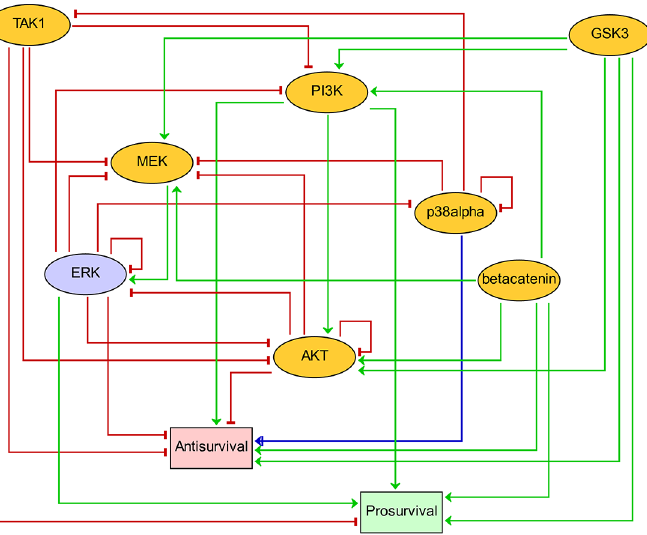
Fig 3. Reduced logical model obtained by semi-automated reduction of the comprehensive logical model shown in Fig 2. The reduced model encompasses all seven drug targets (yellow) and the two phenotypic outputs (red for Antisurvival and green for Prosurvival). In addition the ERK node (blue) had to be preserved to maintain dynamical consistency with the large model. Activating regulations are denoted by green arrows, while red T arrows denote inhibition. The blue arc with both arrow and T head (p38alpha to Antisurvival) indicates a dual regulation, i.e. activating and inhibiting, depending on context. In some contexts p38alpha inhibition will increase Antisurvival, while in others p38alpha inhibition will decrease Antisurvival (see S1 Text, S7 and S8 Tables). Note that after model reduction two members of the Wnt/ β -catenin pathway, β -catenin and GSK3, became non-regulated and fixed at either the on-state ( β -catenin) or off-state